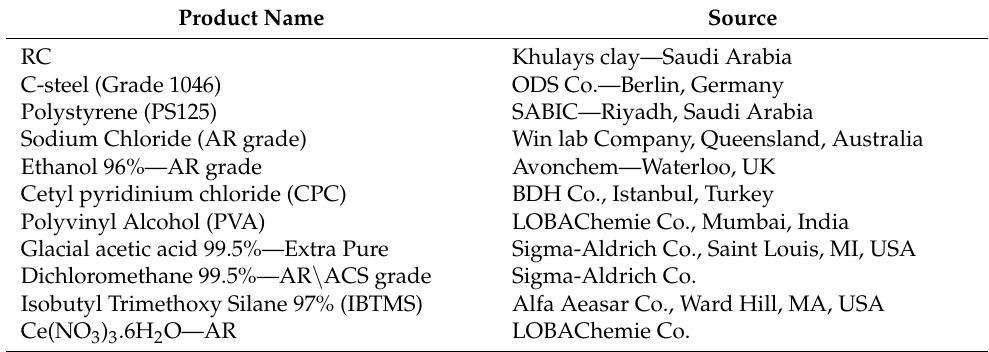
Table 2. The material used in this